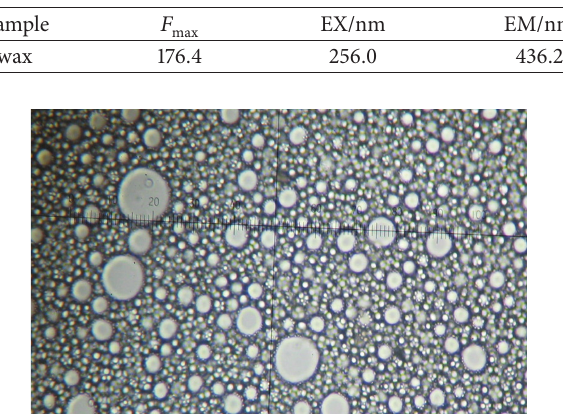
Table 6: Fluorescence performance of Ewax.